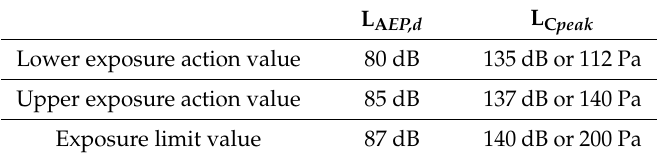
Table 5. Exposure action and limit values under Physical Agents (Noise) Directive